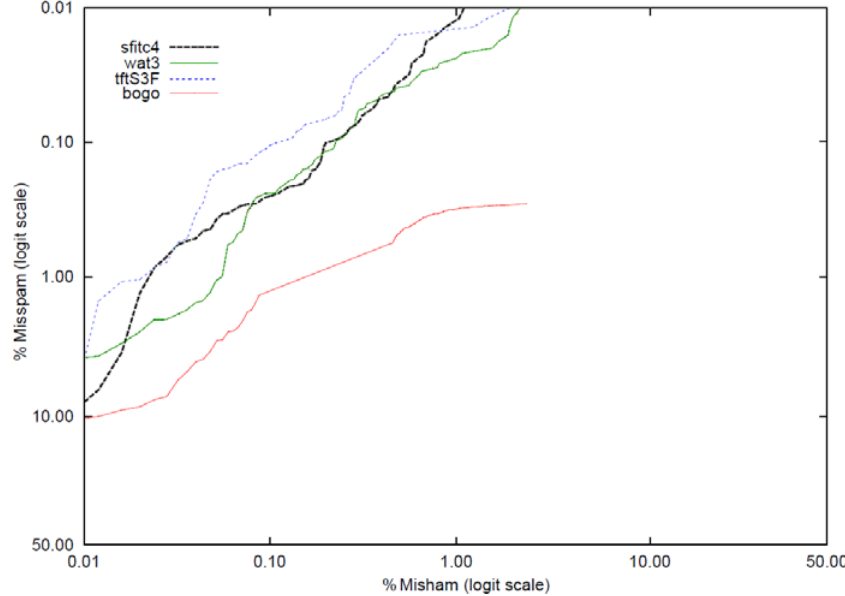
Fig. 5. ROC Curves: Immediate Full Feedback on the Trec07p